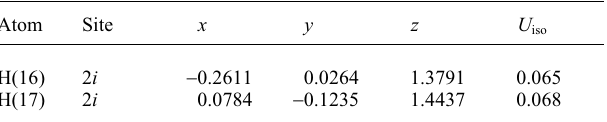
Table 3. Atomic coordinates and displacement parameters (in Å 2 )